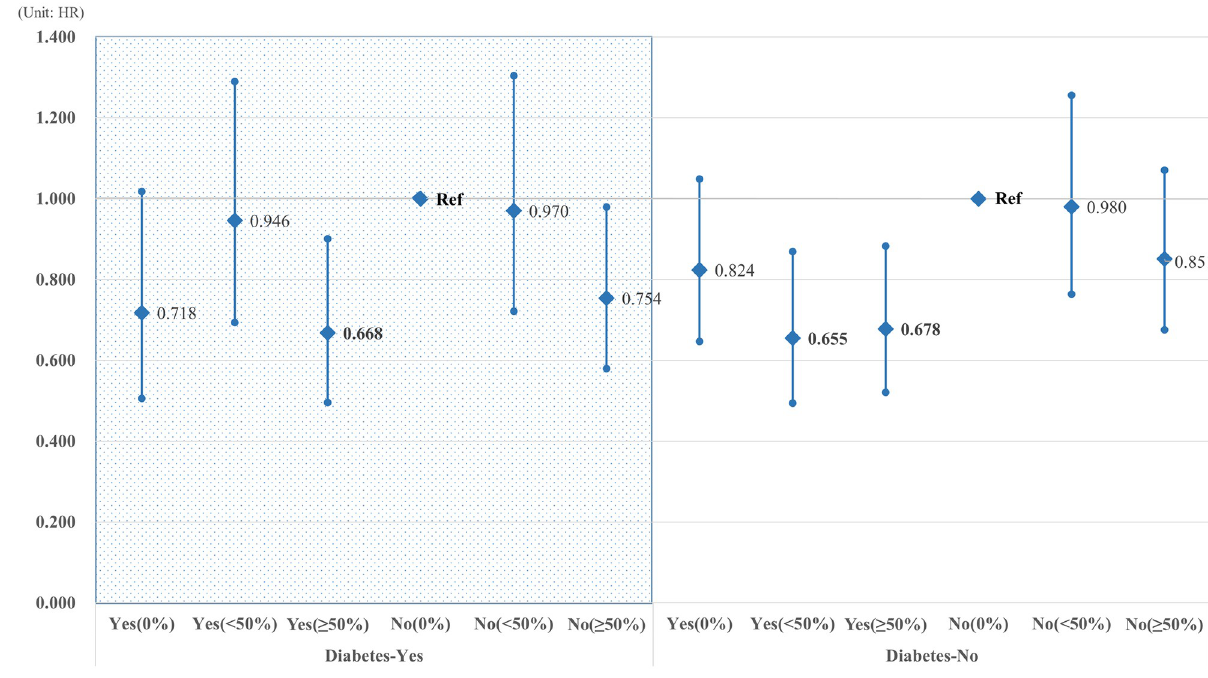
Fig 2. The association between statin use and CRC risk in patients with or without diabetes. Bold is statistically significant.